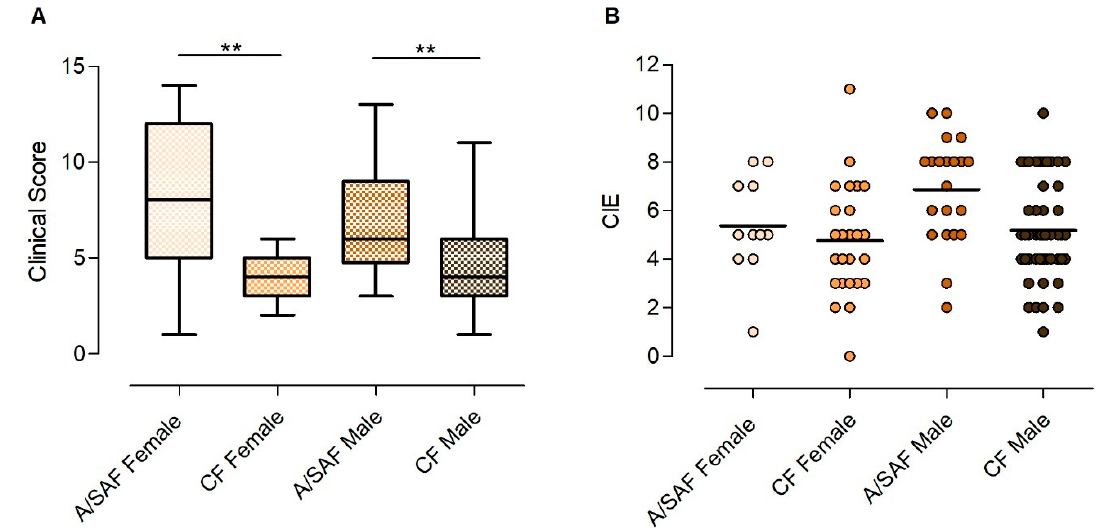
Figure 1. ( A ) Clinical score of the paracoccidioidomycosis patients on admission, according to the clinical form and gender (acute/subacute form (A/SAF) and chronic form (CF)). Medians, interquartile ranges, and min./max. ** p < 0.01. ( B ) Quantitation of anti- Paracoccidioides brasiliensis antibody titers by counterimmunoelectrophoresis (CIE) in the serum of paracoccidioidomycosis patients on admission, according to the clinical form and gender. Each dot represents a patient; the lines denote medians.